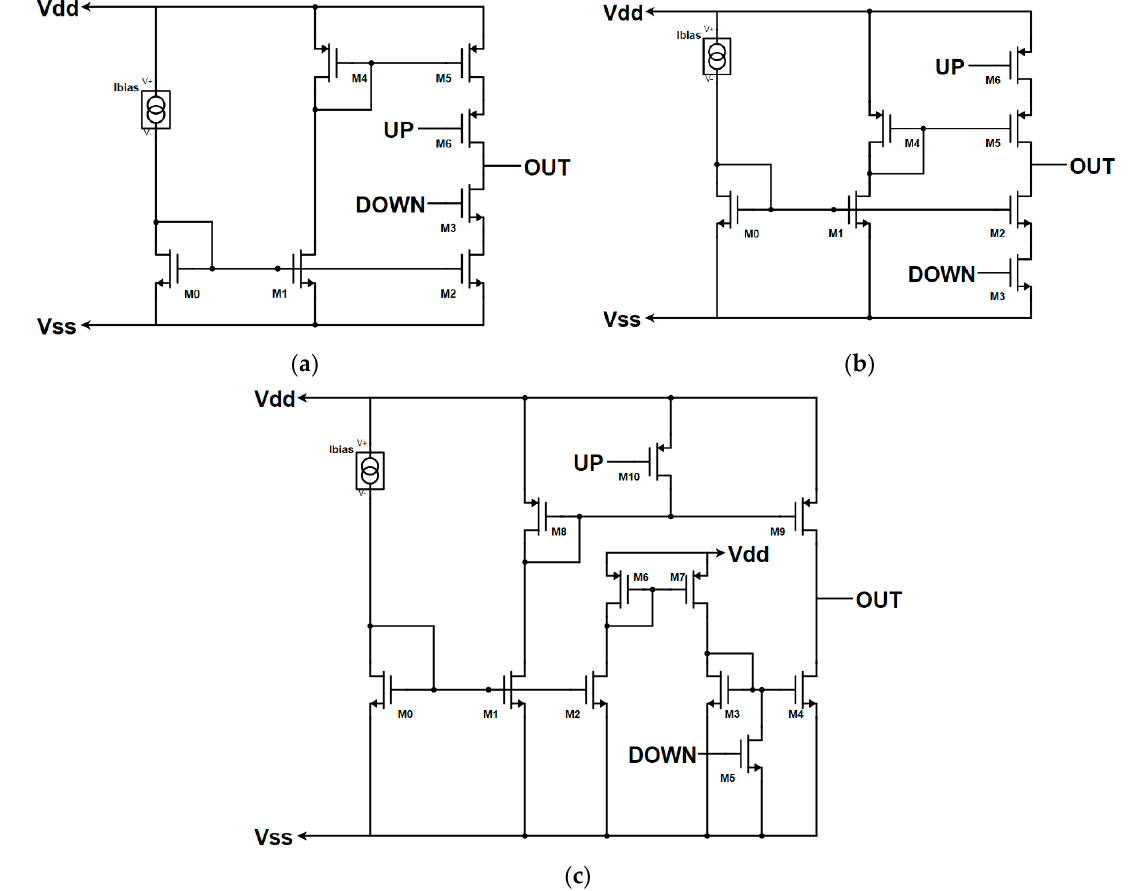
Figure 7. Charge Pump’s architectures: ( a ) Drain Switching architecture, ( b ) Source Switching architecture, ( c ) Gate Switching architecture.